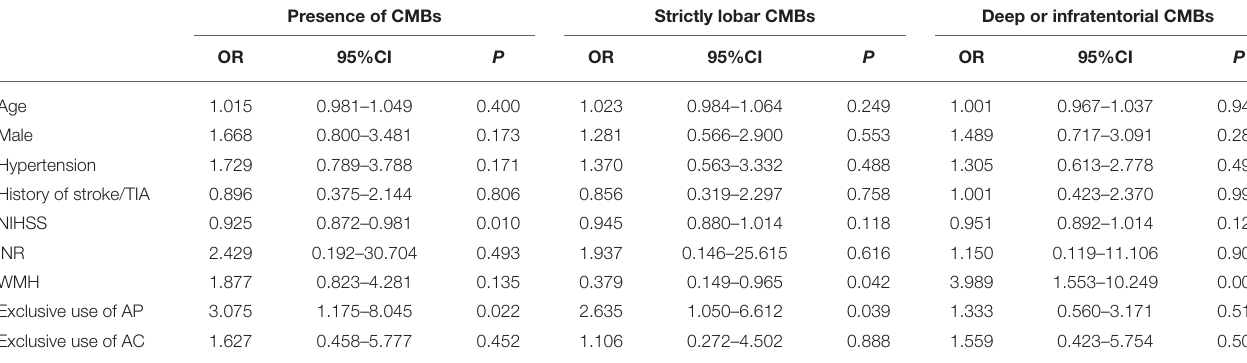
TABLE 3 | Multivariate logistic regression analysis for the association between antithrombotic therapy and cerebral microbleeds. Presence of CMBs Strictly lobar